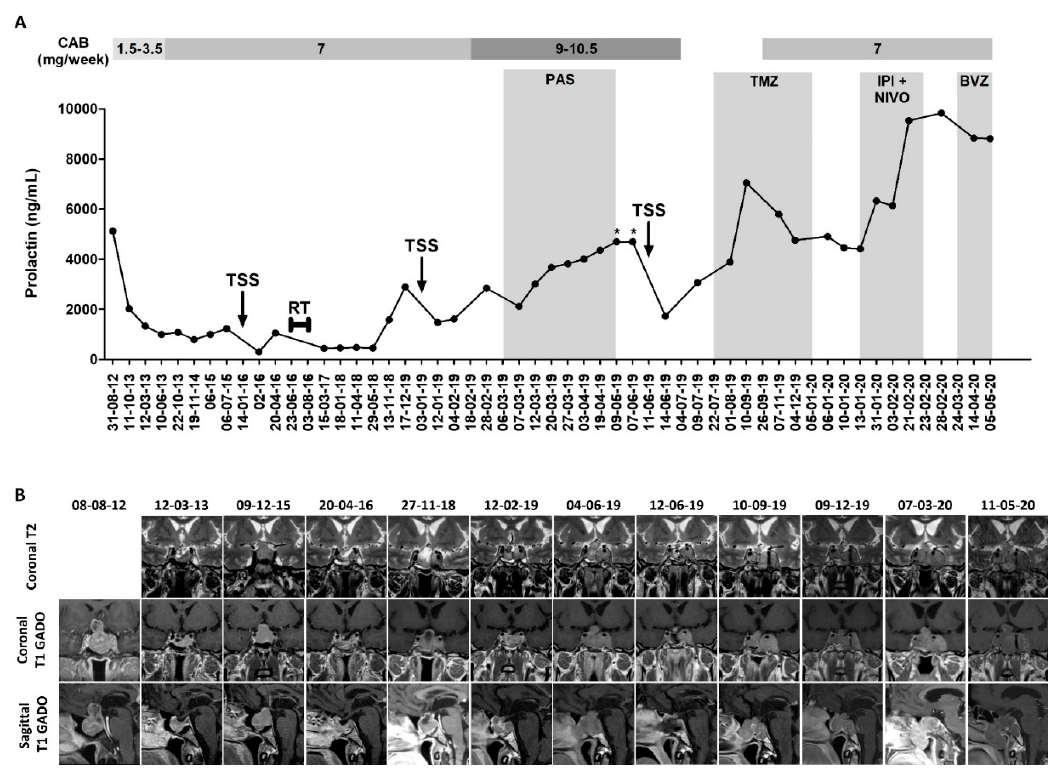
Figure 2. Eight-year follow-up of an aggressive prolactinoma (patient #2), from diagnosis to the present day. ( A ) Evolution of the prolactin levels under the different treatments. Every dot represents an individual measurement. * ≥ 4700 ng/mL (the upper limit of the respective prolactin assay). ( B ) Radiological evolution of the pituitary mass as seen on the magnetic resonance imaging.